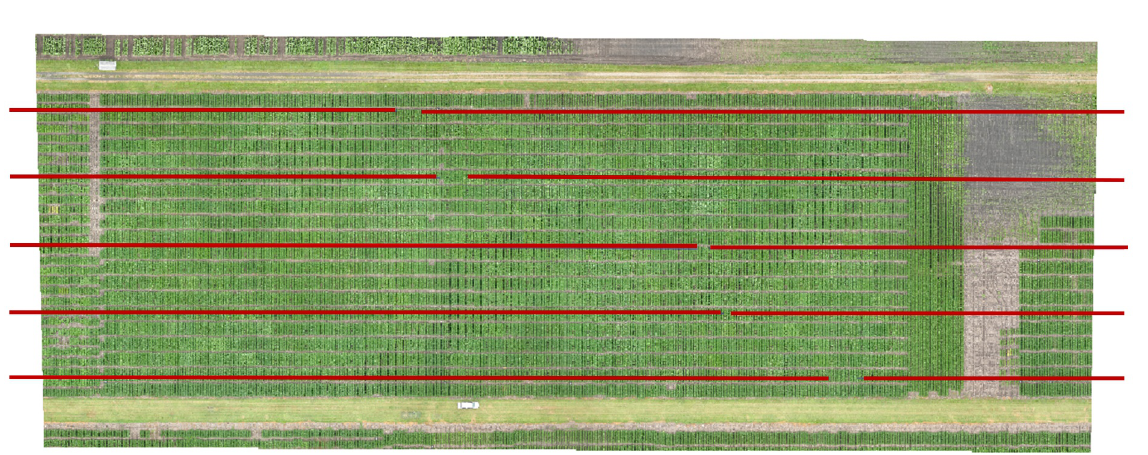
Figure 2. Study field with tile lines overlap in red.